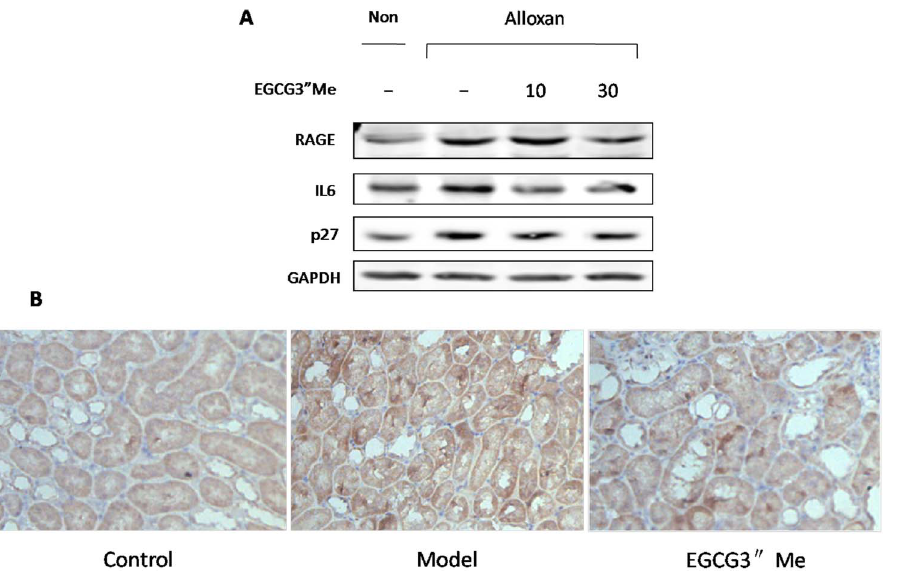
Figure 8. EGCG3’’Me decrease RAGE, IL6, p27 protein levels in diabetic kidney. (A), Western blot analysis of RAGE, IL6, and p27 expression was carried out in diabetic kidney compared with control; (B), Immunochemistry analysis of RAGE (brown) in diabetic kidney, which indicating that EGCG3’’Me inhibited the development of diabetic nephropathy and other complications of diabetes.